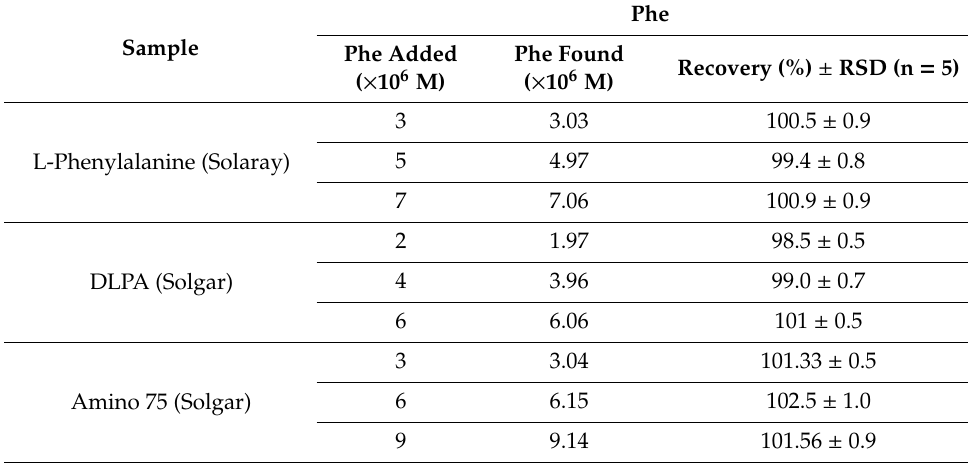
Table 5. The results of the recovery